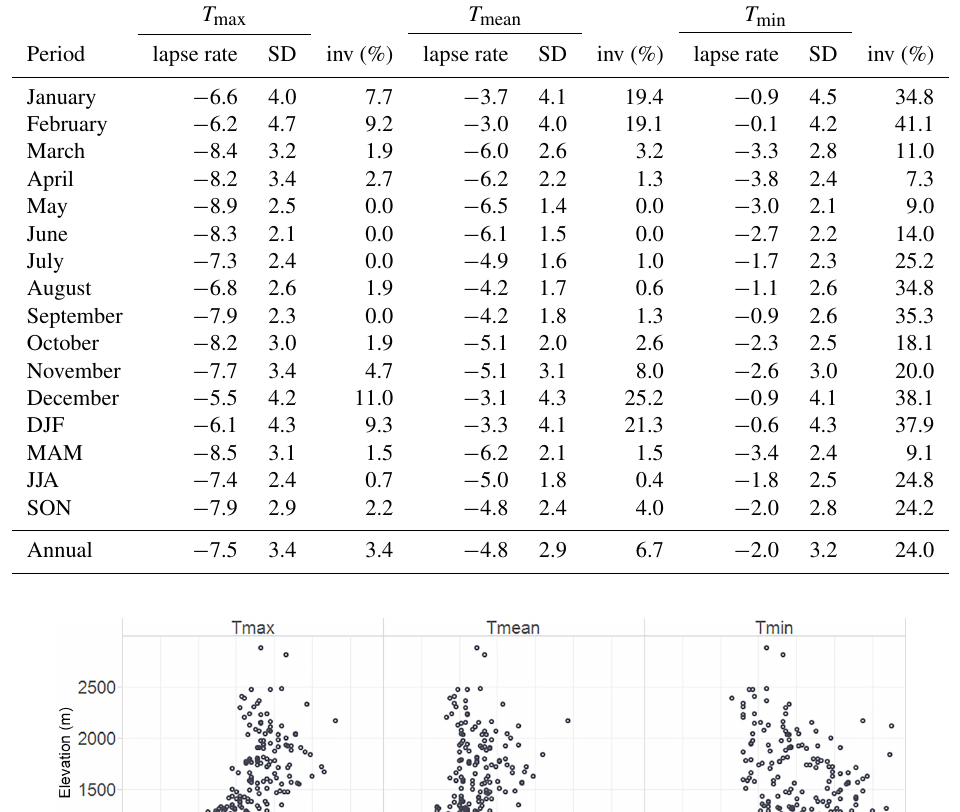
Table 6. Mean and standard deviation (SD) of temperature lapse rates ( ◦ Ckm − 1 ) and inversion frequency (%) for daily minimum, maximum, and mean temperature, by month and season.